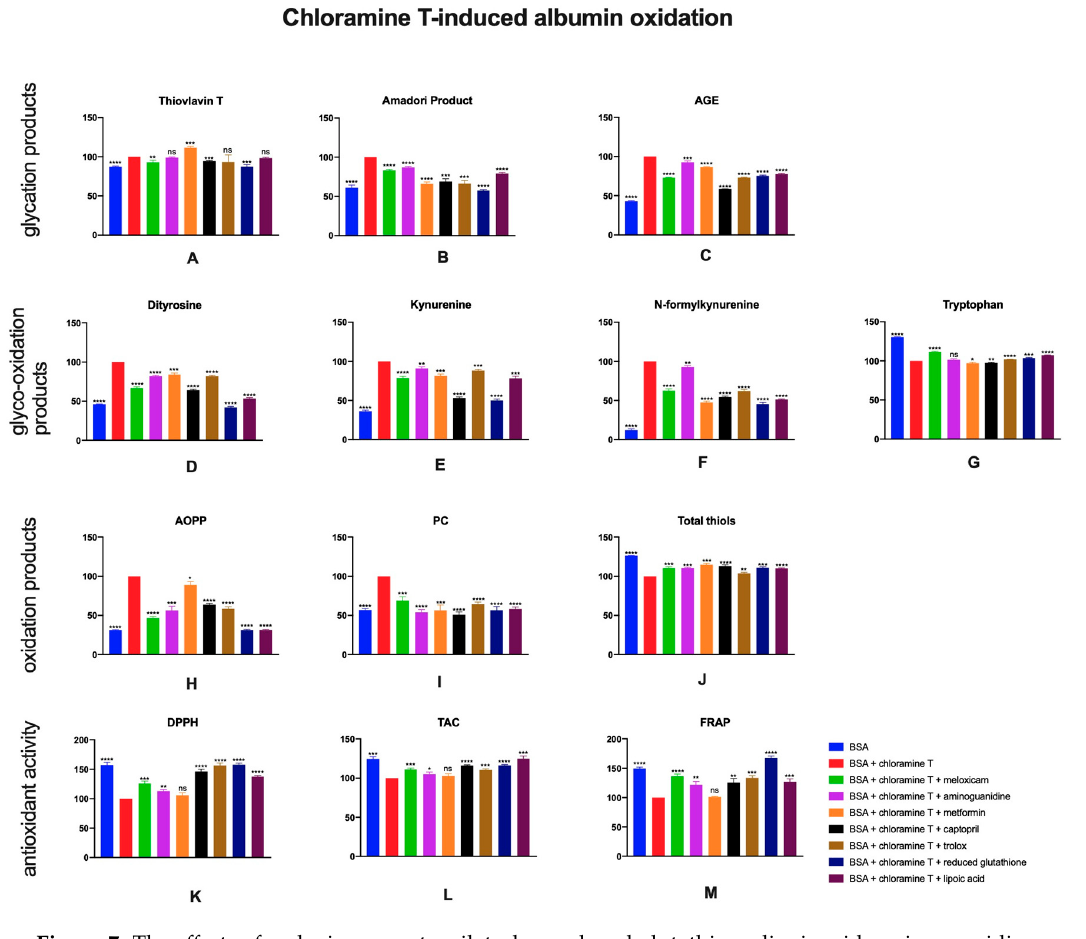
Figure 7. The effects of meloxicam, captopril, trolox, reduced glutathione, lipoic acid, aminoguanidine